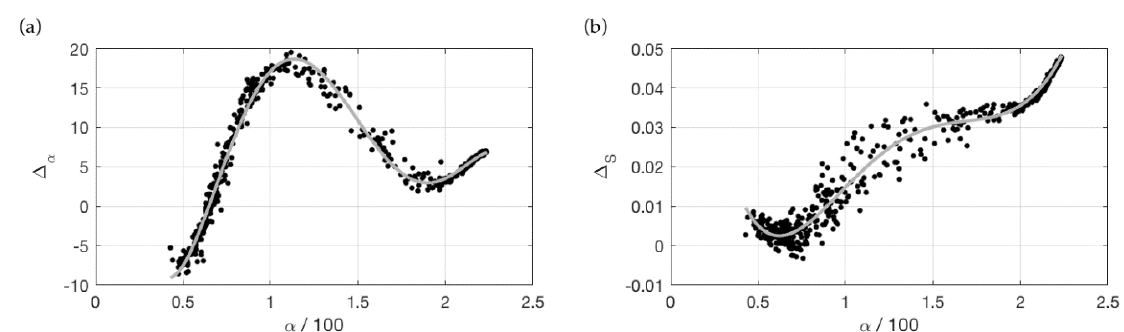
Figure 4. ( a ) Deviation in degrees from the hyperspectral hue angle for the OLI instrument. The horizontal axis gives the hue angle based on the reconstructed spectra (scaled by 100 for practical reasons). The drawn line is the fifth order polynomial fit to the data. ( b ) Deviation in distance ( S ) of the hyperspectral distance from the universal white point.